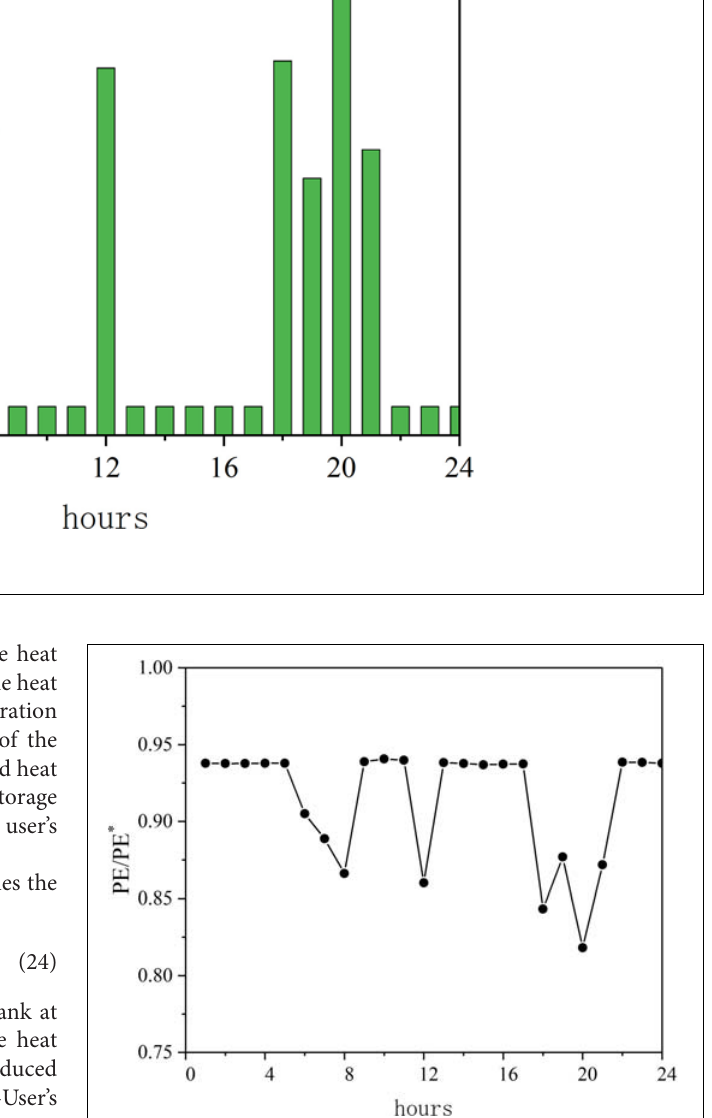
FIGURE 5 | Typical hourly energy consumption ratio in